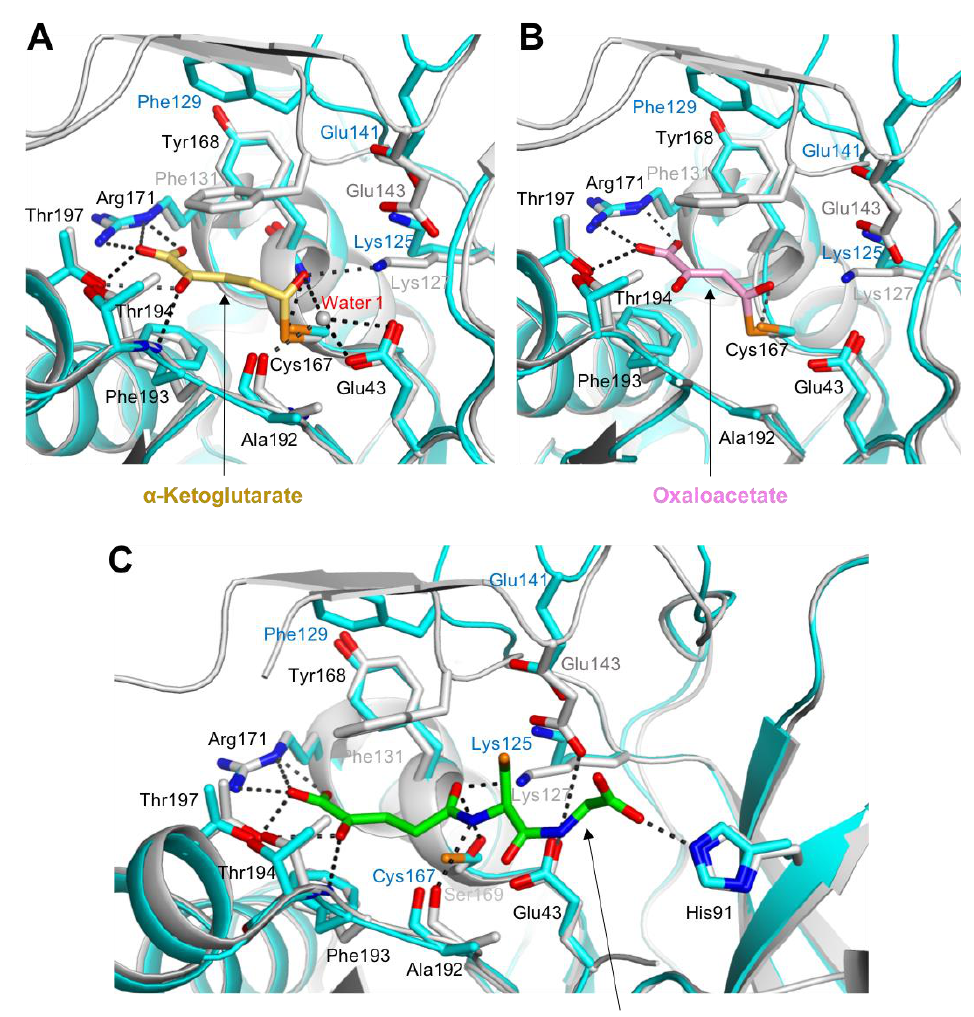
Figure 3. Superposition of the KlNit2 and ScNit2 ligand complex structures. ( A ) Detailed view of the interaction between α -ketoglutarate and overlaid KlNit2 with Nit2 from Saccharomyces cerevisiae (ScNit2; PDB code, 4HG3). Residues from KlNit2 with ScNit2 are shown in cyan and gray, respectively; α -ketoglutarate is shown in yellow. Water molecule 1 is shown as a gray sphere. ( B ) Detailed view of the interaction between oxaloacetate (OAA) and overlaid KlNit2 with ScNit2 (PDB code, 4HG5). The residues from KlNit2 with ScNit2 are shown as in Figure 3A. The OAA is shown in pink. ( C ) Detailed view of the interaction between a peptide-like ligand and overlaid KlNit2 with ScNit2 (PDB code, 4HGD). The residues from KlNit2 with ScNit2 are shown as in Figure 3A. The ligand is shown in green. The figures were generated using the graphics program PyMOL (Schrödinger Inc., New York, NY,